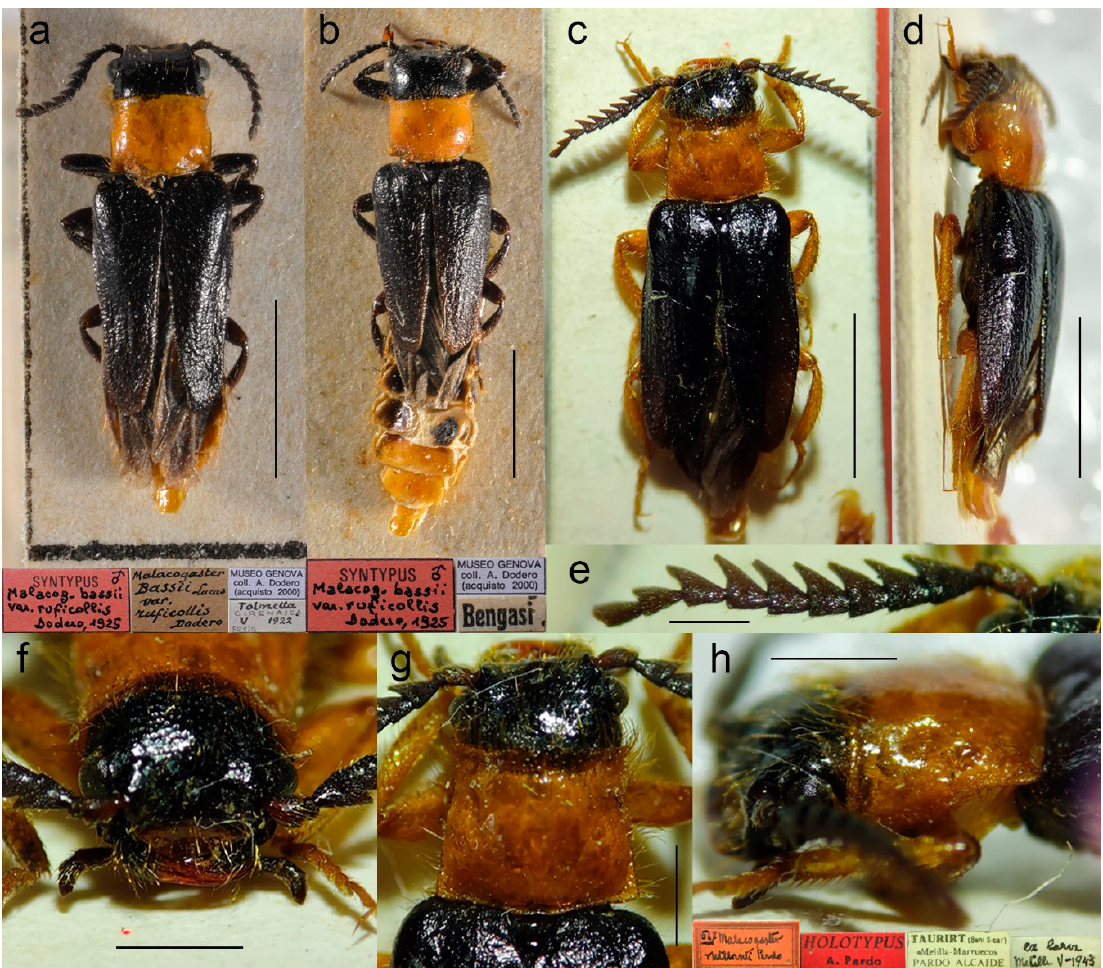
Figure 21. Malacogaster ruficollis Dodero, 1925, stat. nov., male syntypes. ( a ) Syntype from Tolmetta, habitus, dorsal view; ( b ) Syntype from Benghazi, habitus, dorsal view. Malacogaster rutllanti Pardo Alcaide, 1945, male holotype. ( c ) habitus, dorsal view; ( d ) habitus, lateral view; ( e ) left antenna; ( f ) head, frontal view; ( g ) pronotum, dorsal view; ( h ) pronotum, lateral view. Scale bars = ( a , b ) 2.5 mm; ( c , d ) 3.0 mm; ( e ) 0.5 mm; ( f – h ) 1.0 mm. Photographs of M. ruficollis courtesy of R. Poggi (MSNG). Photographs of M. rutllanti courtesy of G. O. Muñoz (MUNA).